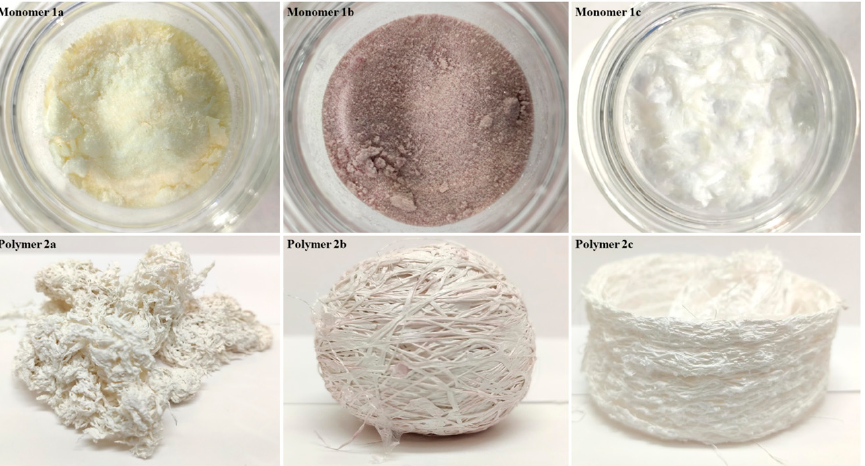
Figure 1. Photographic images of the thiol ‐ functionalized norbornene dicarboximide monomers ( top ) and their corresponding ROMP ‐ prepared raw polymers ( bottom ).